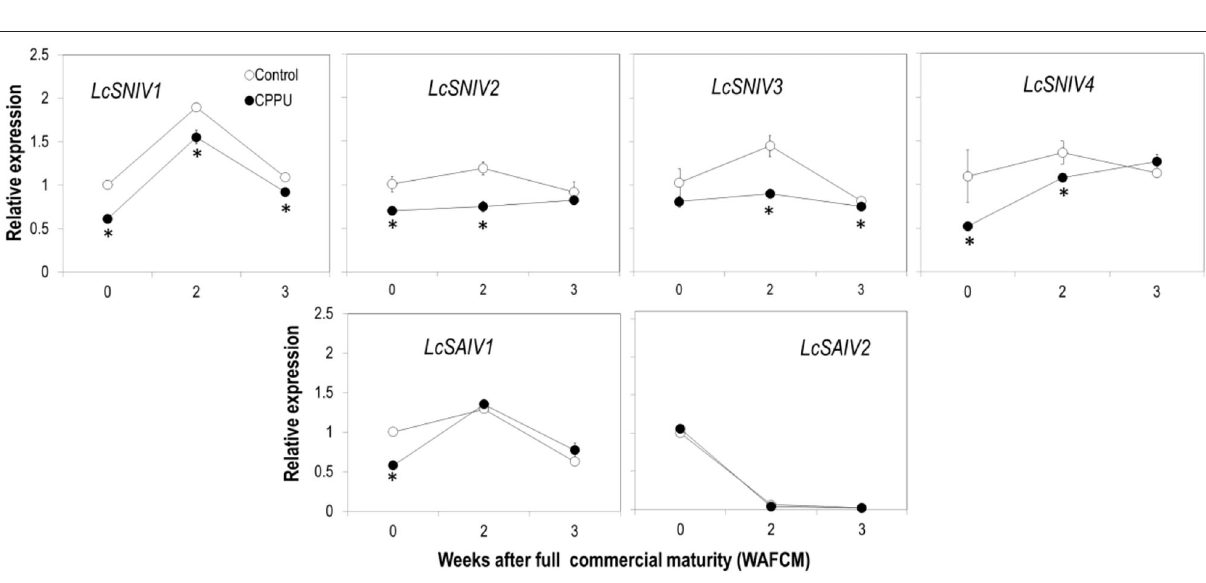
FIGURE 9 | Effects of preharvest application of CPPU on expression of genes encoding SNIVs ( LcSNIV1 , LcSNIV2 , LcSNIV3, and LcSNIV4 ) and SAIVs ( LcSAIV1 and LcSAIV2 ). Vertical bar at each data point stands for standard error ( n = 5). *Indicates significant difference between CPPU treatment and the control at p < 0.05, Student’s t